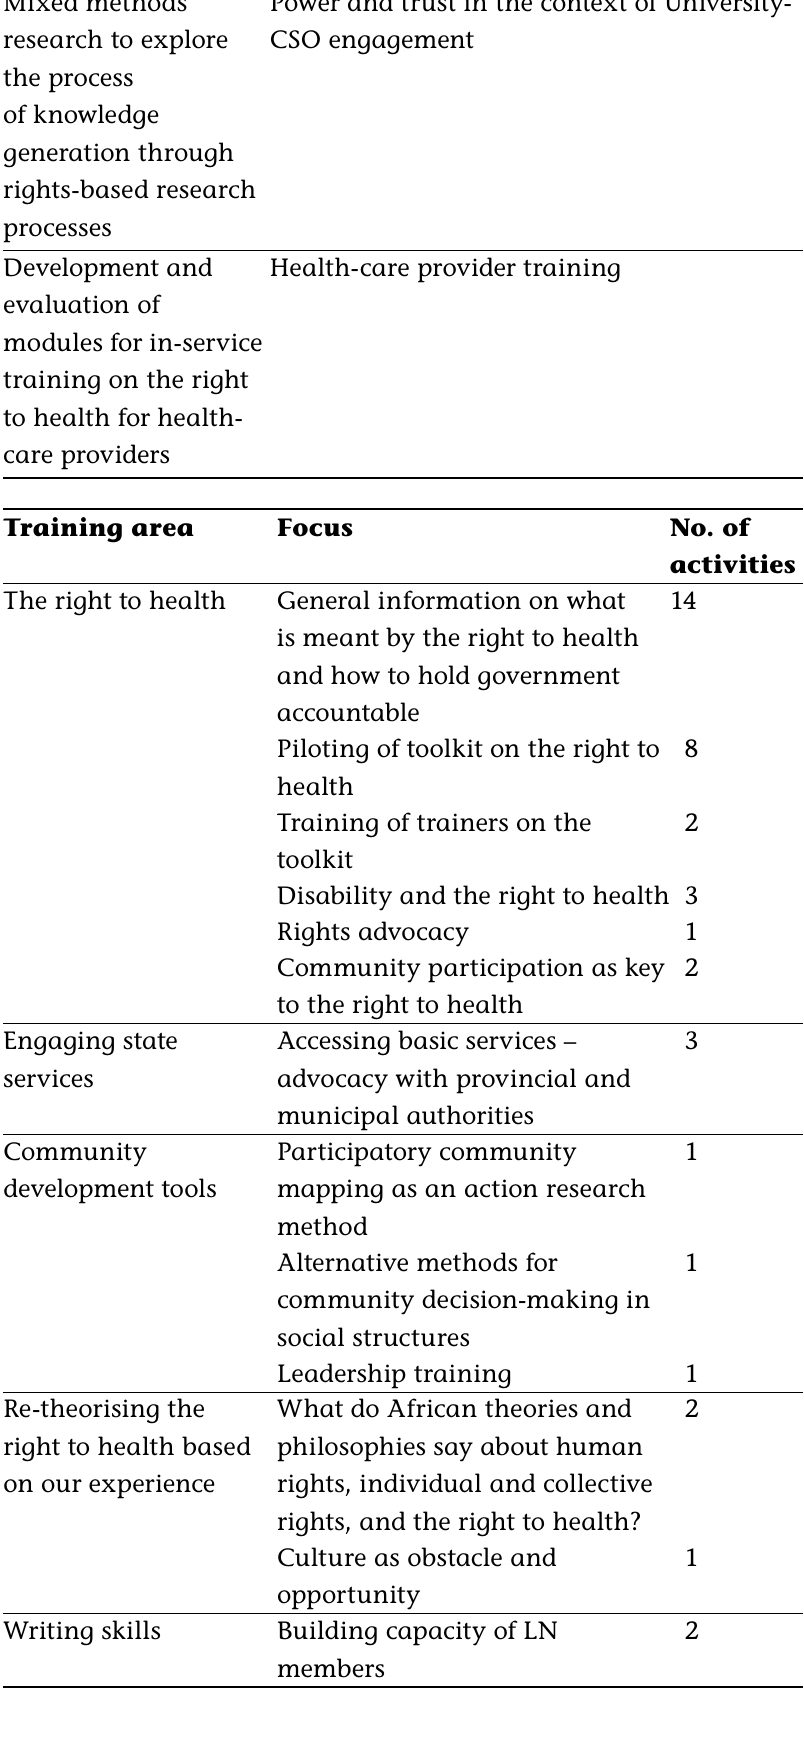
Table 2: Co-learning activities undertaken within the LN (adapted from London et al.